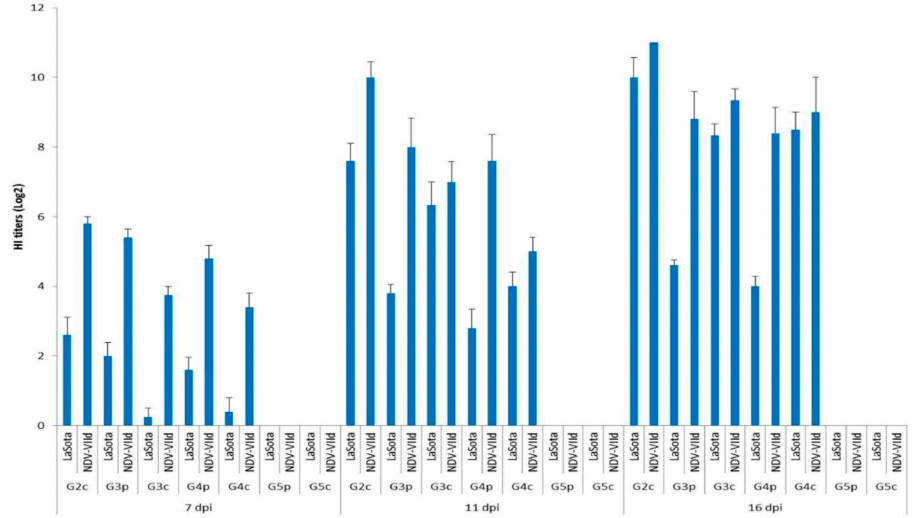
Figure 7. Mean HI titres (log2) for all bird groups at 7, 11, and 16 dpi using LaSota and NDV-VIId antigens. G1c: n = 10, G2c: n = 10, G3p: n = 15, G3c: n = 5, G4p: n = 15, G4c: n = 5, G5p: n = 10, and G5c: n =